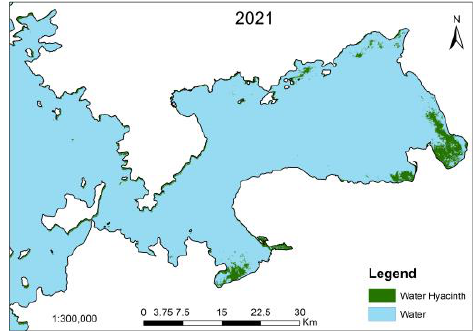
Figure 6 : Shows the extent and the coverage location of E. crassipes in Lake Victoria in January of 2020. The graph below depicts the trend of water hyacinth coverage from 2017 to 2021, with a sharp increase in 2020, and a sharp decrease in 2018.